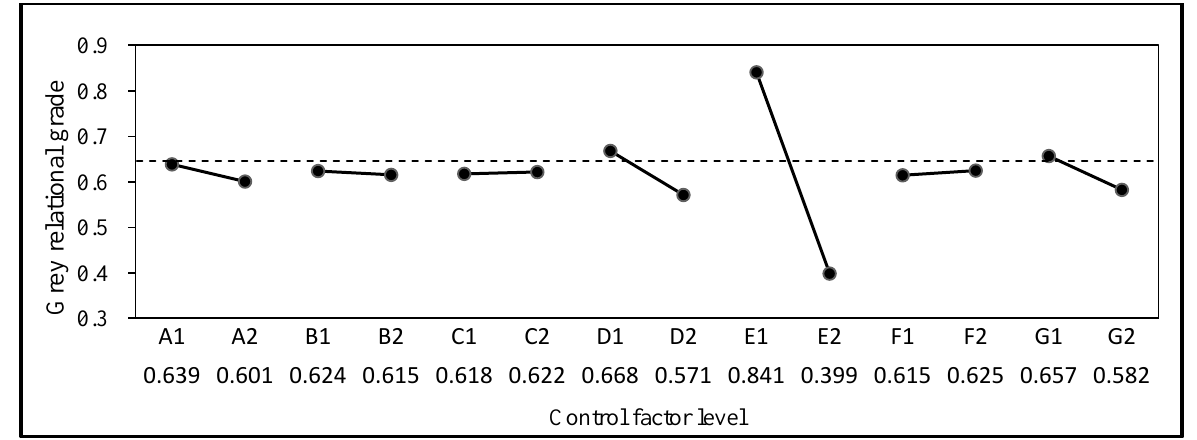
Figure 6. Grey relational grade responses graph for multi-quality factors.